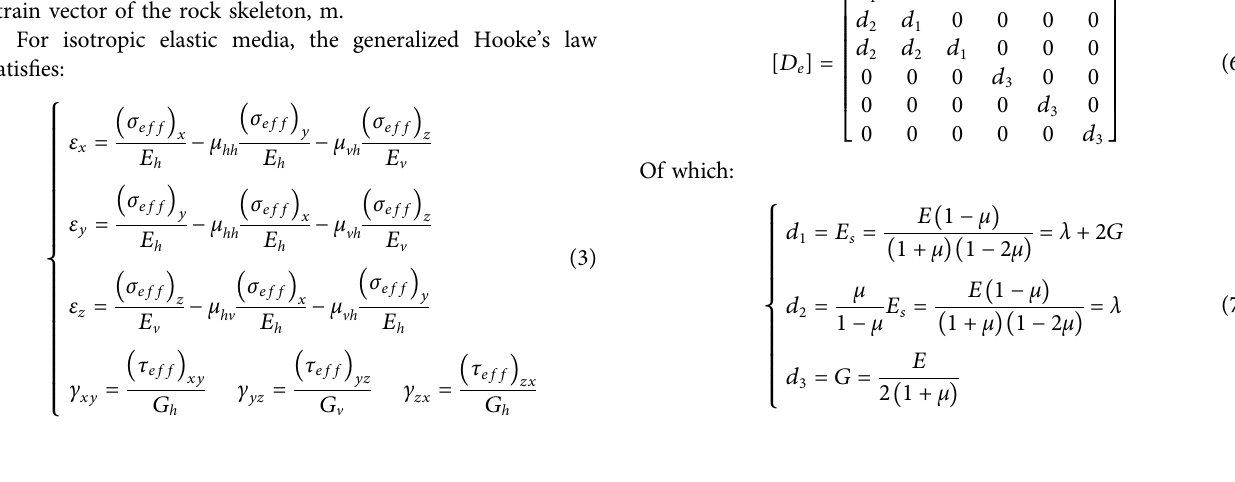
(cid:8) σ (cid:9) (cid:1) f ({ ε }) (2 ) eff Where { σ eff } is the stress vector of the rock skeleton, m; { ε } is the strain vector of the rock skeleton, m.